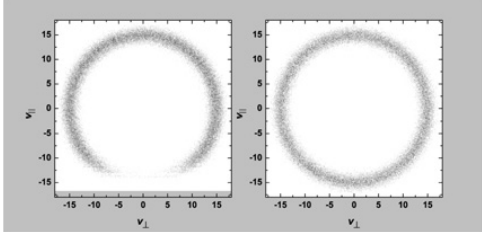
Figure 2. A ring shell distribution and a deformed ring shell (horseshoe) distribution.